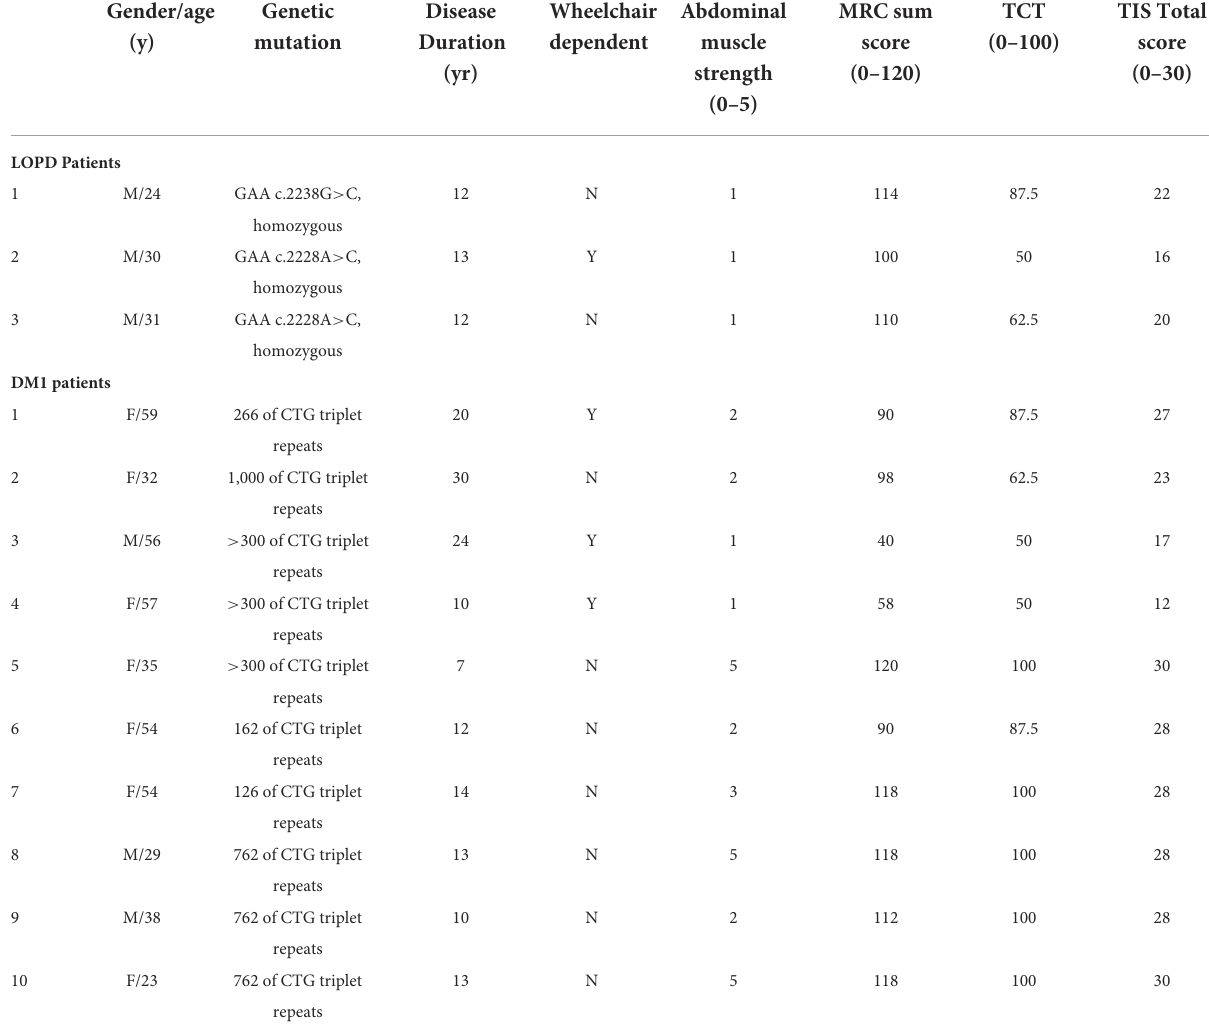
TABLE 1 Demographic and functional data in late-onset Pompe disease and Myotonic dystrophy type